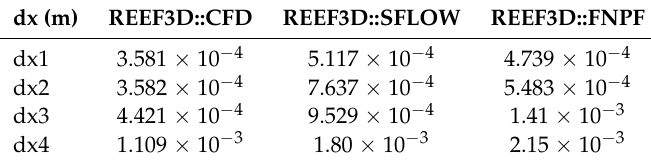
Table 3. Mean square root errors for wave height in the grid convergence study for the 2D regular Stokes 2nd-order wave simulation using the three modules. The notations dx1 to dx4 represent the finest and coarsest cell size in the tests of each of the modules.